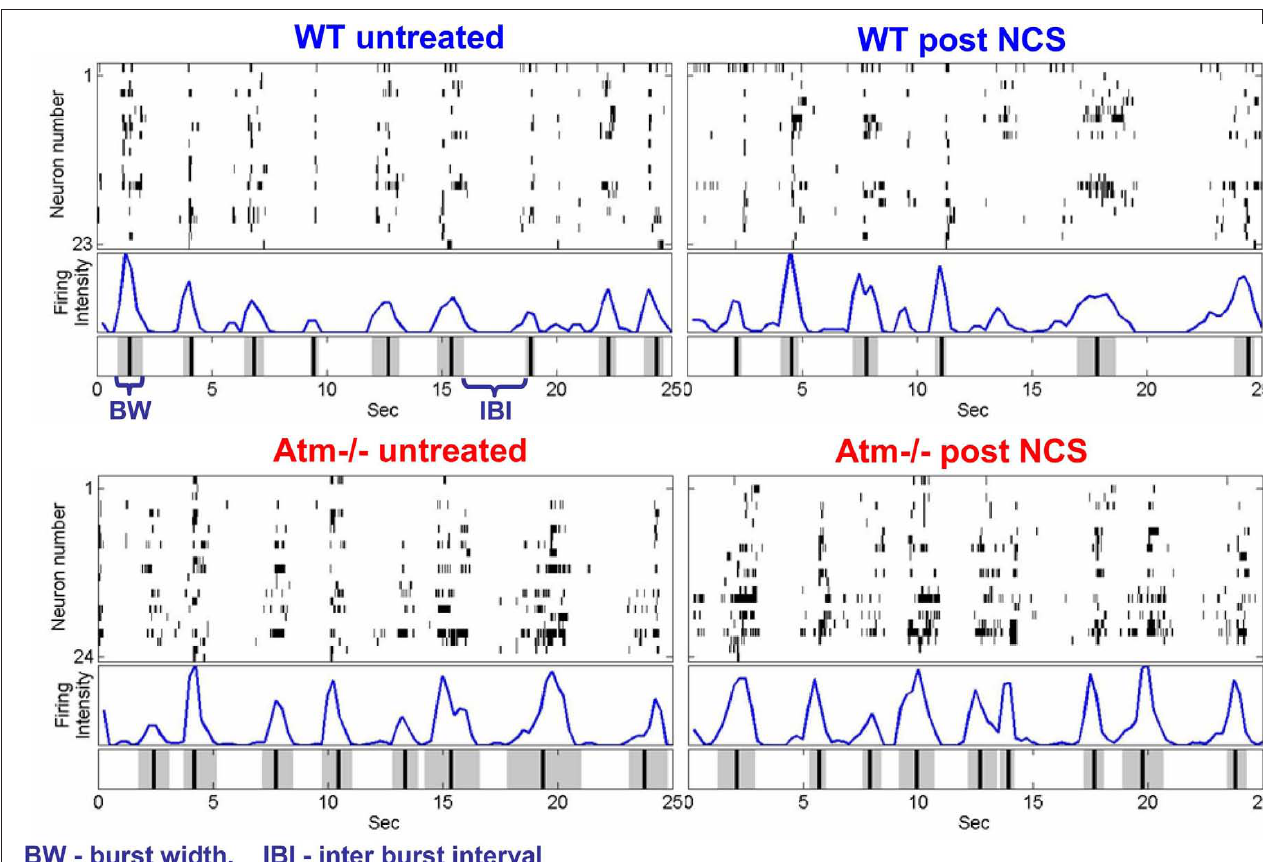
Figure 2 | raster plots, firing rate, and burst detection in WT and Atm-deficient cultures. A raster plot of the network’s activity, shown in (top window), each black line in a row represents a detected spike of a neuron in time. The grouping in time of neuron spikes into bursting events demonstrates a characteristic spatio-temporal structure (fingerprint). (Middle window), we plot